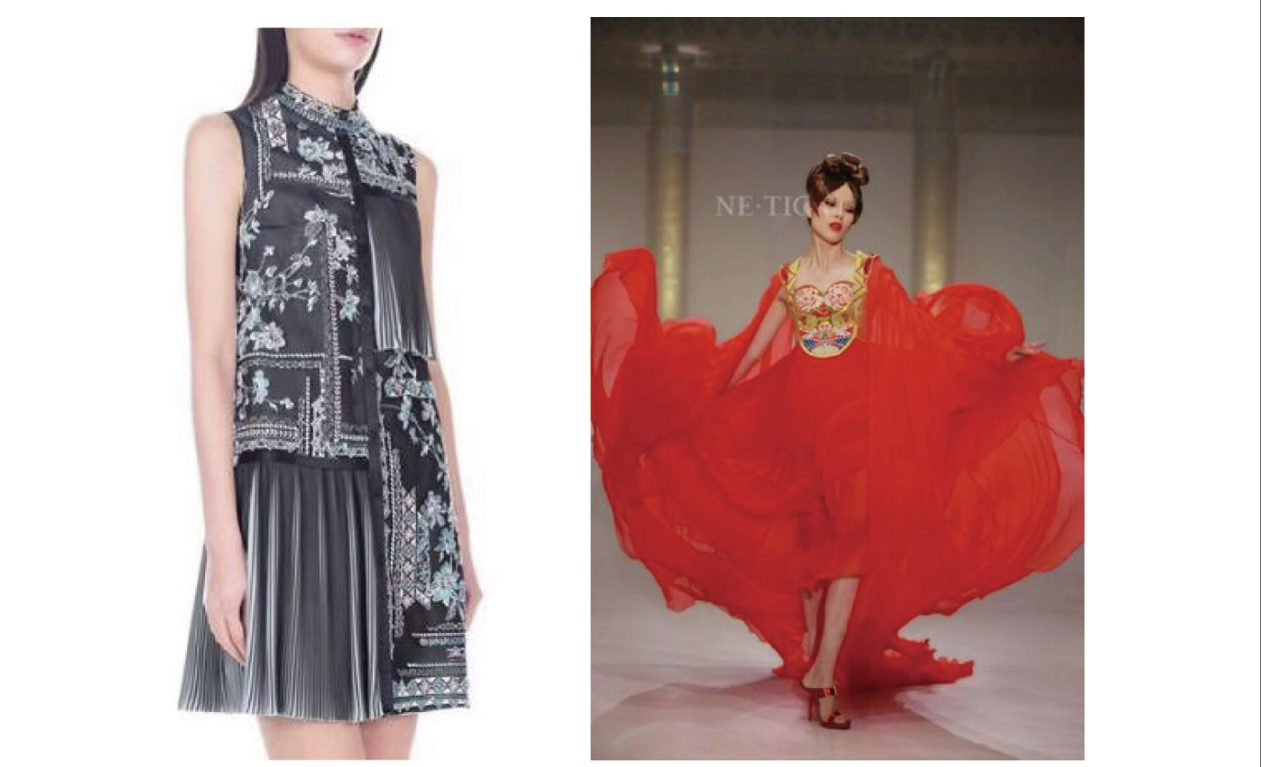
FIGURE 2 | Alxa’s pasture, goats and herdsmen, and the best clothes made from the discarded cashmere. The photo displayed on the left was taken and kindly provided by Shiatzy Chen’s brand manager Mr. Sun. The photo displayed on the right was taken and kindly provided by Ne Tiger’s retail manager Mrs.